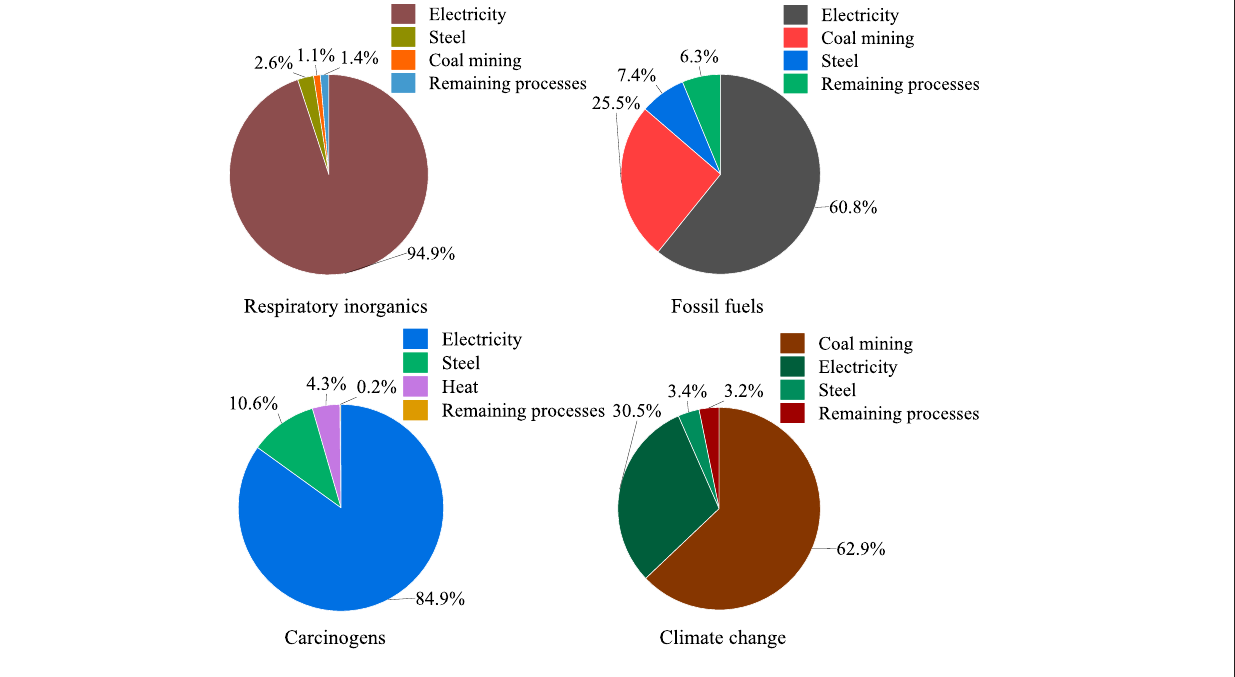
FIGURE 7 | Process contribution analysis